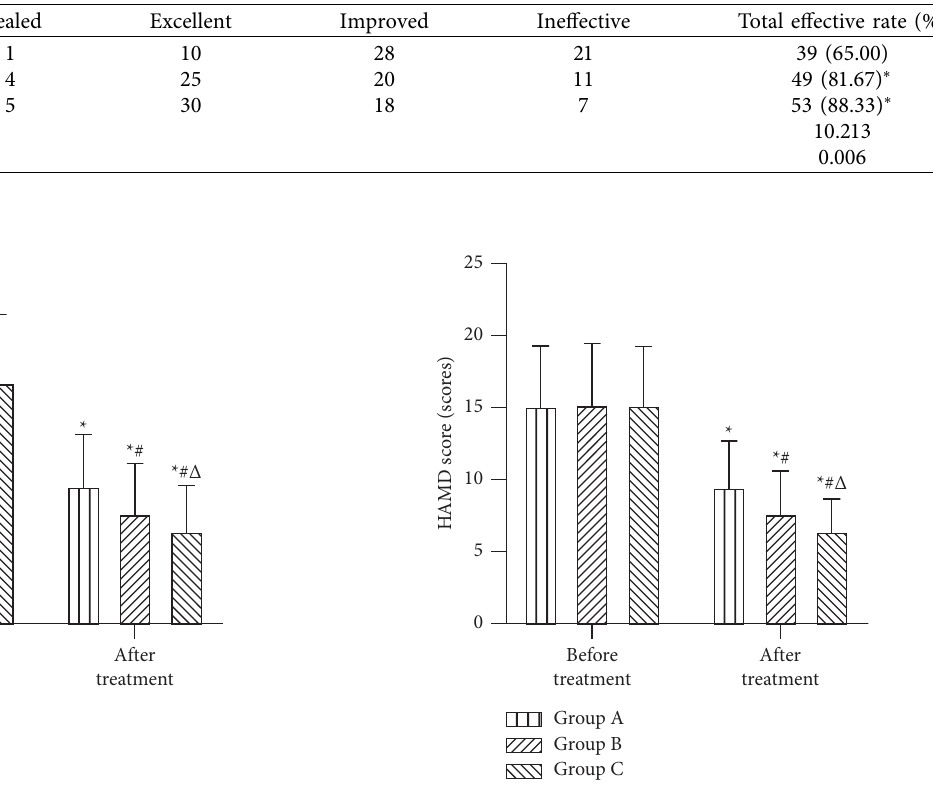
Figure 4: Comparison of 3 groups of HAMD scores ( x ± s , scores). Compared with the same group before treatment, ∗ P < 0 . 05; compared with group A after treatment, # P < 0 . 05; compared with group B after treatment, Δ P < 0 .